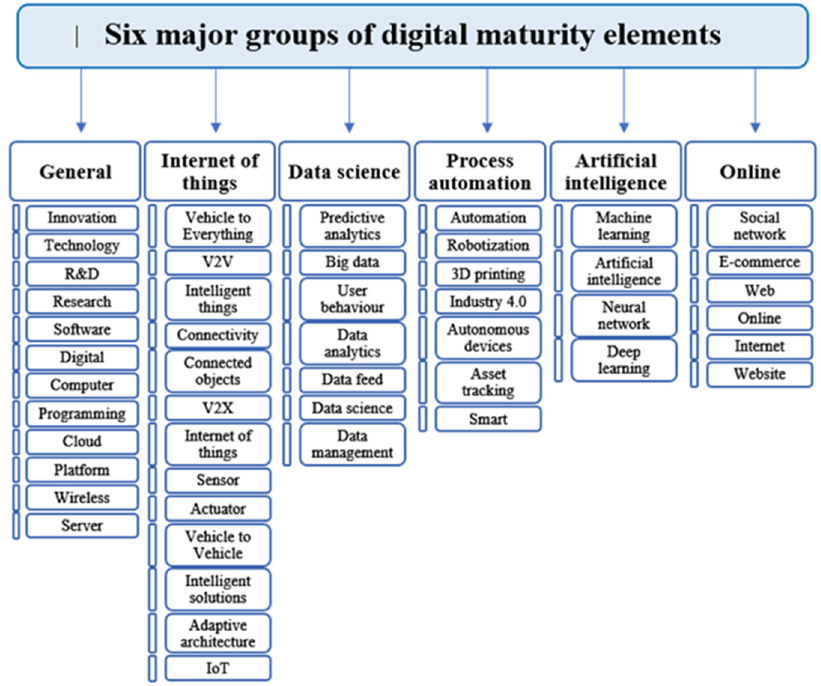
Figure 1. The six major groups of the digital maturity elements (authors).